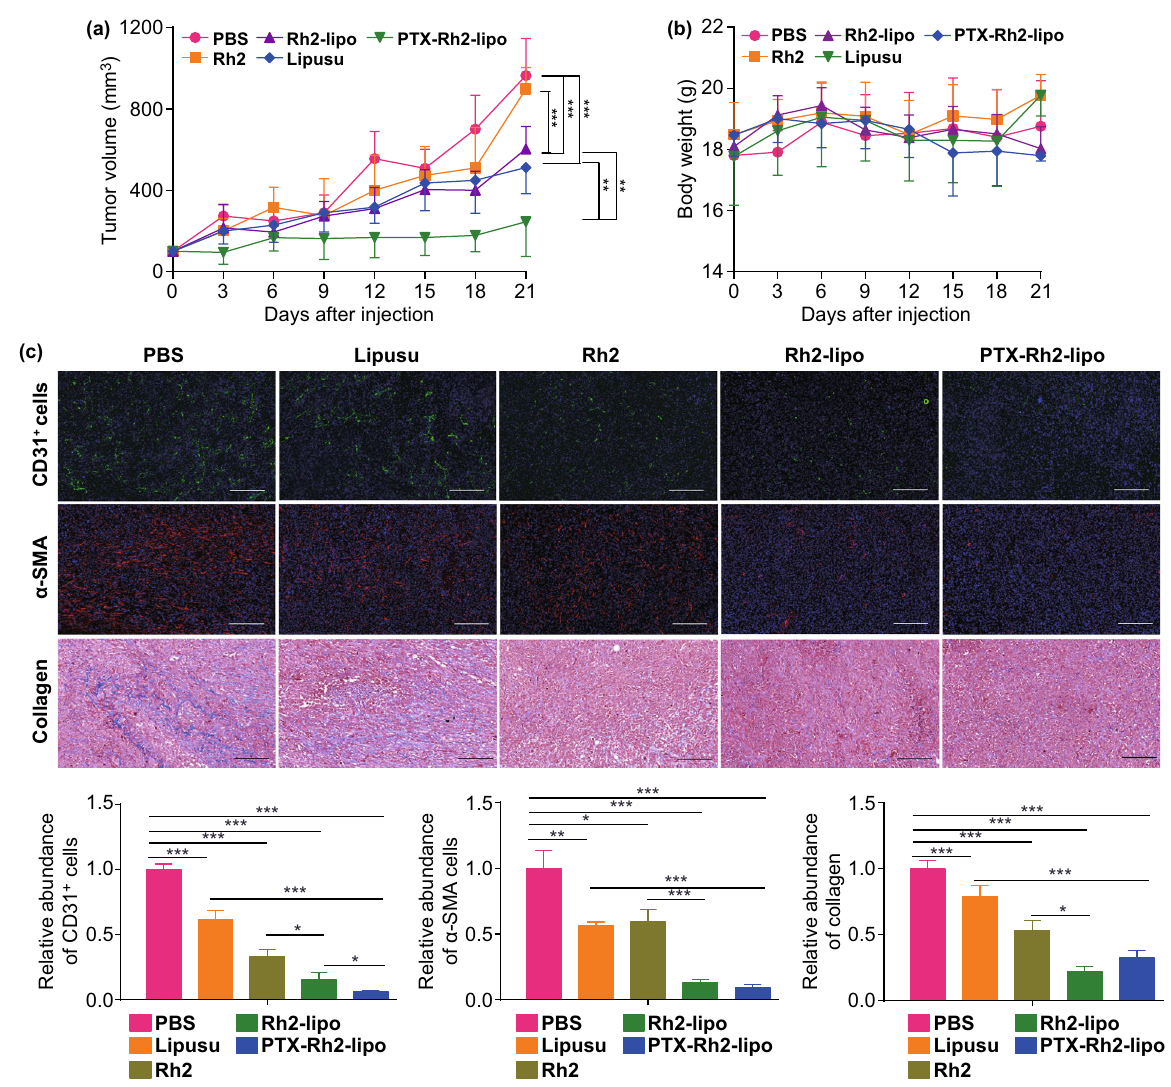
Fig. 6 Rh2 worked as a chemotherapy adjuvant, which suppressed tumor growth and remodeled structure of TME. a 4T1-orthotopic tumor growth curve during PTX loaded Rh2-lipo treatments ( n = 6; mean ± SD). * P < 0.05, ** P < 0.01 and *** P < 0.001. b Body weight of 4T1-ortho- topic tumor model mice treated by different formulations ( n = 6; mean ± SD). c Blood vessels in 4T1 tumors, marked with CD31 antibody (green), were normalized in structure and reduced in expression after treatment; TAFs in tumors, marked with α-SMA antibody (red), were significantly decreased after treatment; Collagen fibers, marked with Masson’s Trichrome, were significantly decreased after treatment. Scale bar = 100 μm. * P < 0.05, ** P < 0.01 and *** P < 0.001, ( n = 3; mean ±